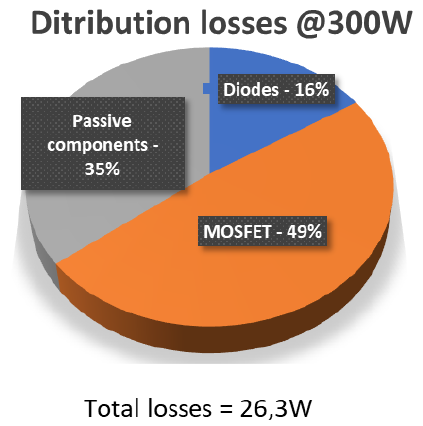
Figure 27. Experimental results for the power-loss breakdown of the converter.